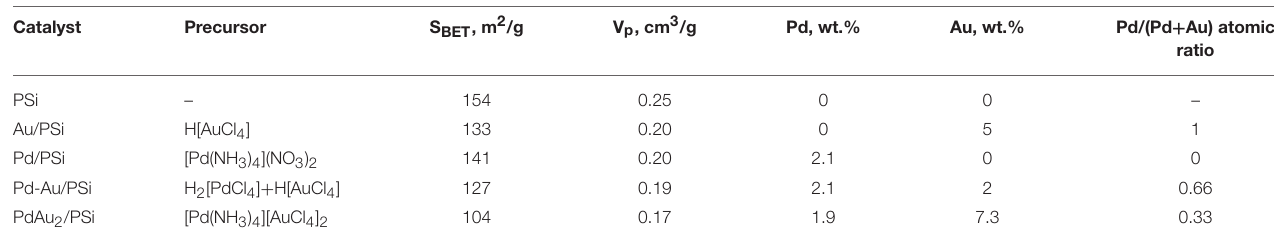
TABLE 1 | Catalyst’s metal loading, specific BET surface area and pore volume.